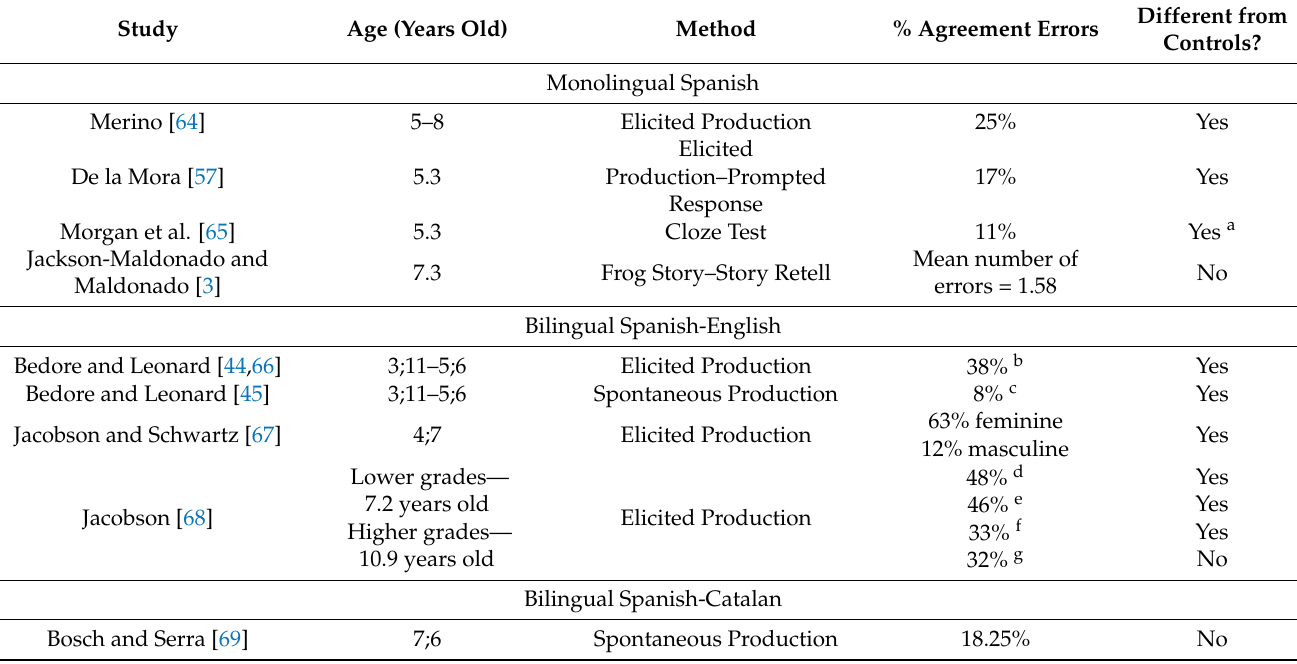
Table 1. Summary of Findings from Previous Studies on Clitic-Antecedent Agreement Errors for Spanish-speaking Children with